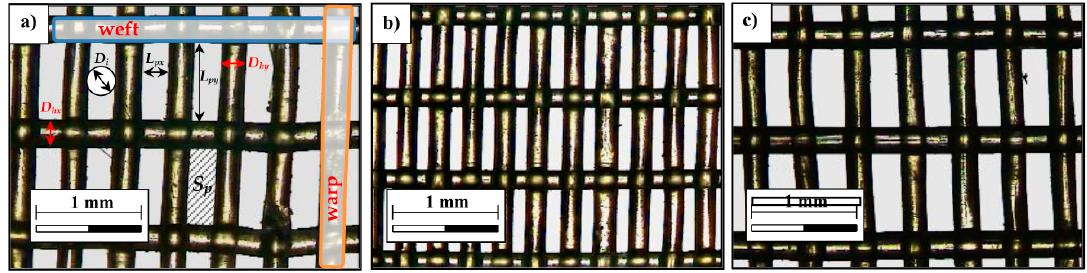
Figure 1. Geometric parameters determined using the methodology developed at University of Almería. Digital microscope images of screen 1 ( a ); screen 2 ( b ) and screen 3 ( c ).